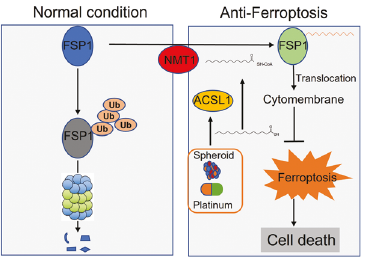
Fig. 6 ACSL1 involvement in anti-ferroptosis in ovarian cancer. During the process of metastasis in the peritoneal cavity,